Question: Describe this figure in one sentence.
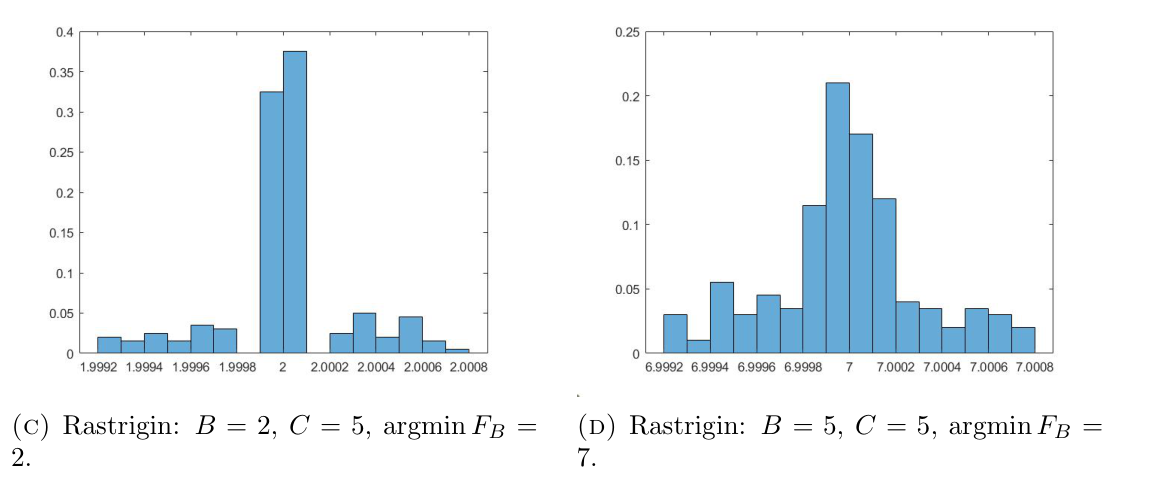
Answer: 3. 1D Rastrigin with B = C = 0. Four iterations of SBGD visu- alized on the Rastrigin landscape show show the dynamics of merged agents and convergence patterns.